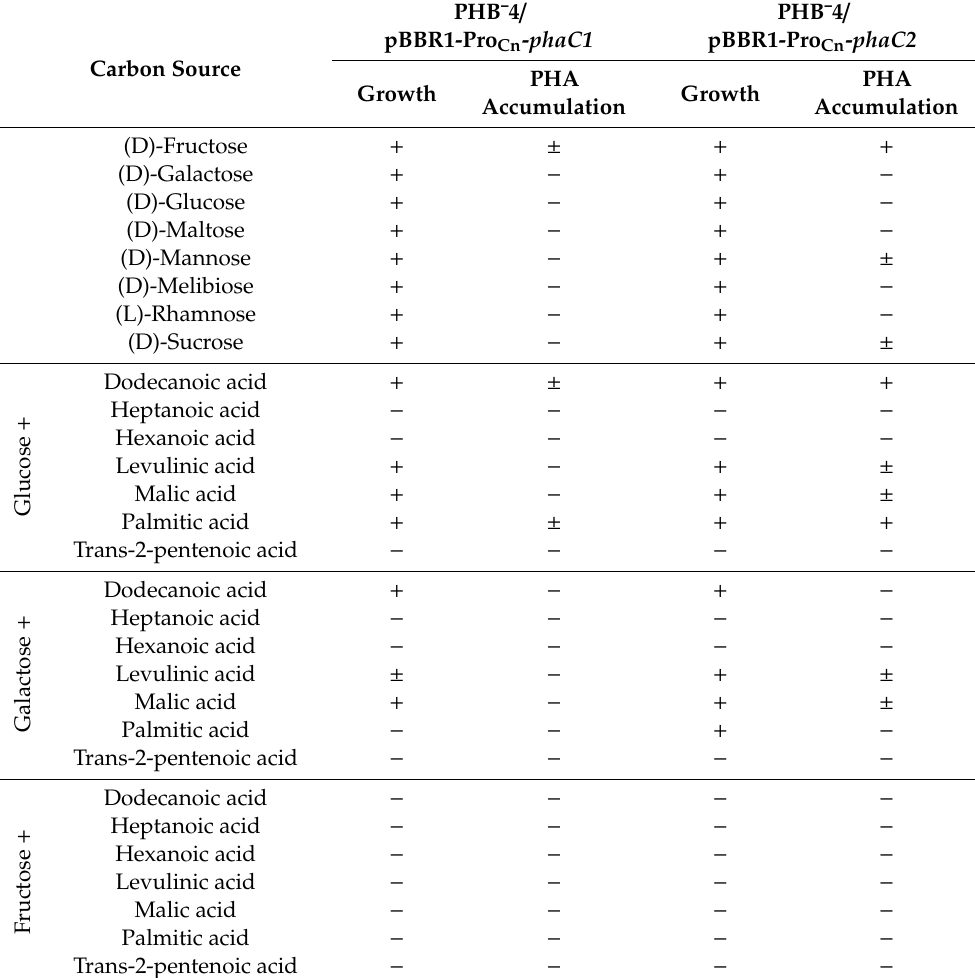
Table 6. Growth and PHA accumulation in transformant strains PHB¯4 / pBBR1-Pro Cn - phaC1 and PHB¯4 / pBBR1-Pro Cn - phaC2 using di ff erent carbon sources. Legend for growth and PHA accumulation +/ − : Positive /